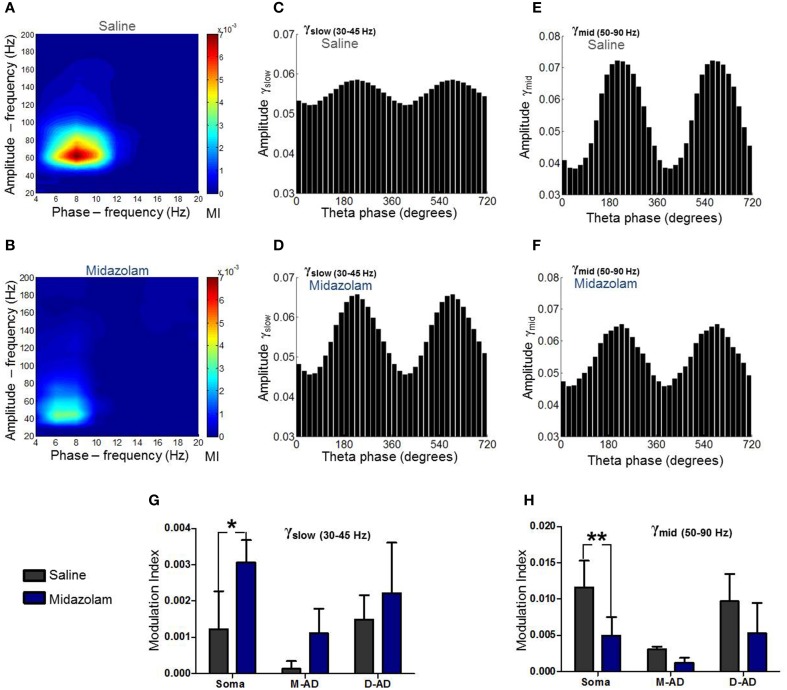
Summary of midazolam effects on θ-γslow and θ-γmid cross frequency coupling. (A) Comodulogram at the somatic recording site following saline administration. (B) Comodulogram following midazolam administration at the somatic recording site, from the same mouse shown in (A). Peak MI values were shifted to lower amplitude- and phase-frequencies. (C,D) γslow amplitude modulation at the somatic recording site as a function of θ-phase following administration of saline (C) or midazolam (D). (E,F) γmid amplitude modulation at the somatic recording site as a function of θ-phase following administration of saline (E) or midazolam (F). (G,H) Grouped data from all animals. Midazolam increased θ-γslow coupling (G) and decreased θ-γmid coupling (H) at the somatic recording site. No significant effects were seen at mid-apical dendrite (M-AD) or distal-apical dendrites (D-AD). *p < 0.05; **p < 0.01.